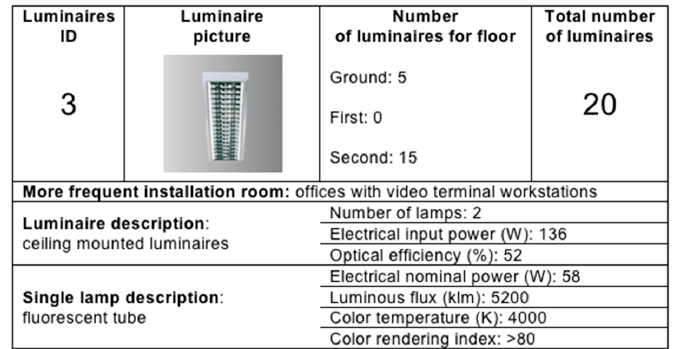
Figure 3. Example of the data collection sheet for a luminaire of the indoor lighting system.